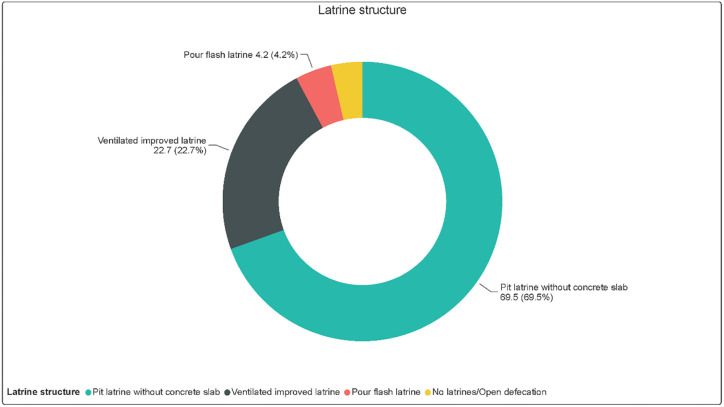
Types of latrines.